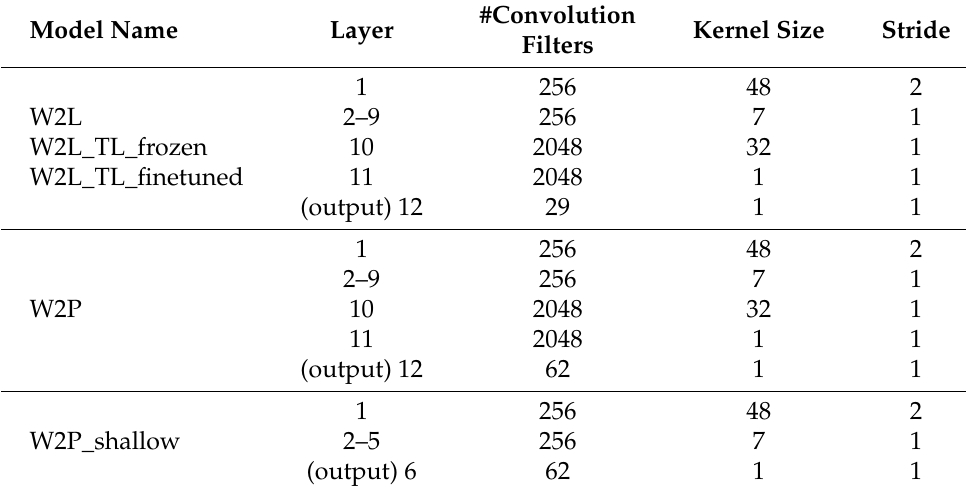
Table 1. Overview of parameters of 1D-convolutional layers in the used models.